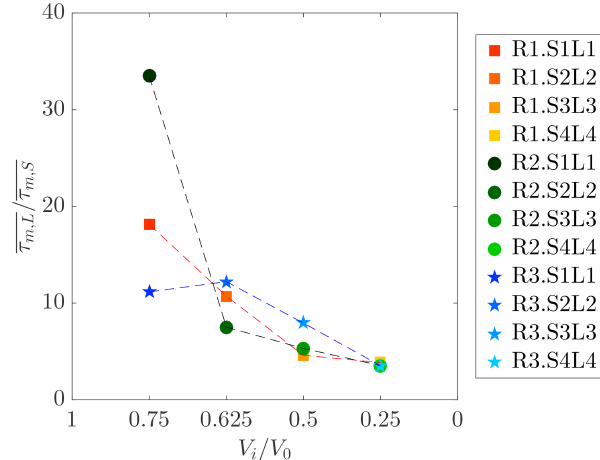
Figure 7. Ratio between time-averaged interface shear stress of tests with varying lock lengths ( τ m , L ) and test with varying lock slopes ( τ m , S ) versus percentage of volume of the upstream lock reach V i /V 0 . Dashed lines link tests performed with the same initial excess density.